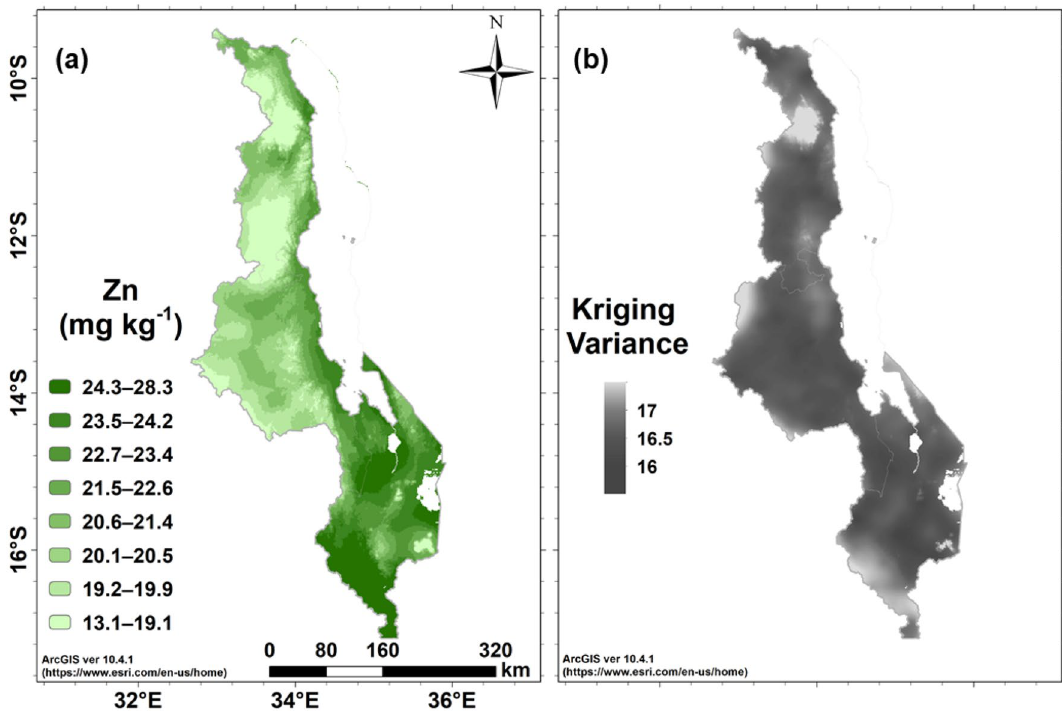
Figure 4. Grain Zn concentration in maize grain across Malawi. ( a ) Empirical Best Linear Unbiased Predictions, and ( b ) the prediction error variance (expected squared error) of the